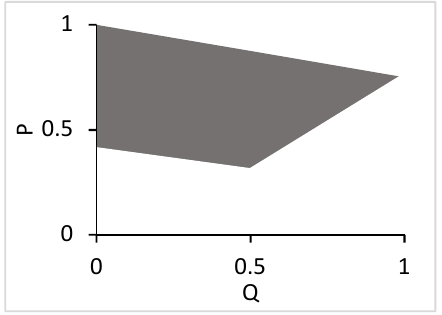
Figure 2. Feasible operating region of a CHP with extraction condensing turbine.